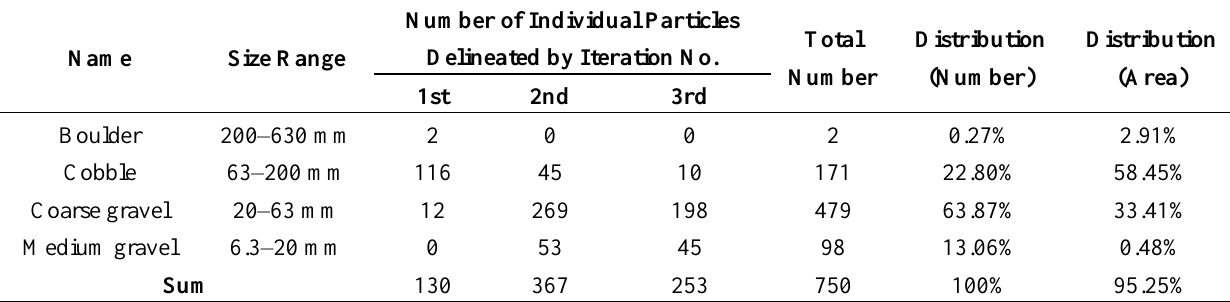
Table 1. Distribution of detected sediment particles (ISO 14688-1 classification system).